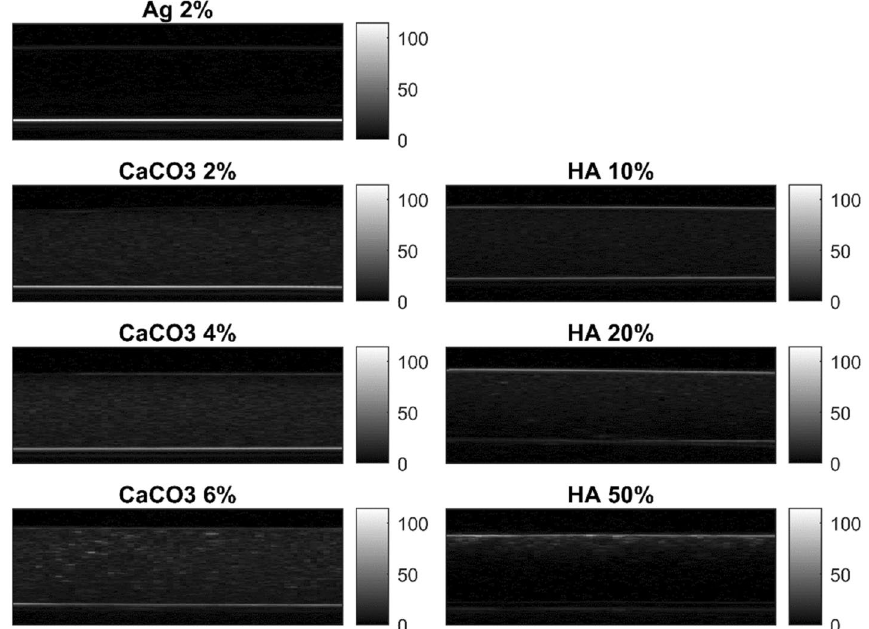
Figure 5. B-mode images of hydrogels. Representative B-scan images of agarose gels without particles (Ag 2%), and with particles at different concentrations: CaCO 3 2%, CaCO 3 4%, CaCO 3 6%, HA 10%, HA 20% and HA 50%. Data were acquired using a transmission wave frequency of 15 MHz. For each image, the color bar shows the pixel